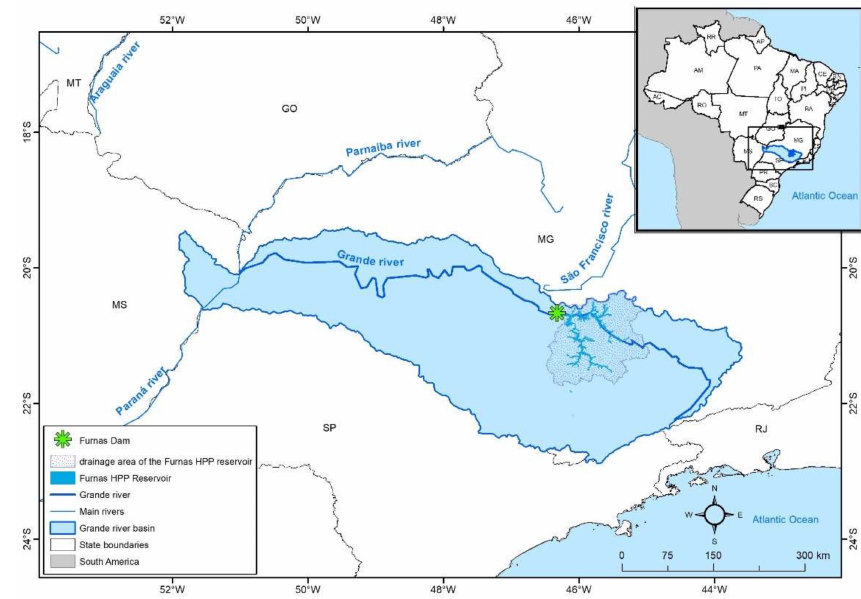
Figure 1. Map of study area: Grande River Basin, Furnas HPP (Hydropower Plant) reservoir,